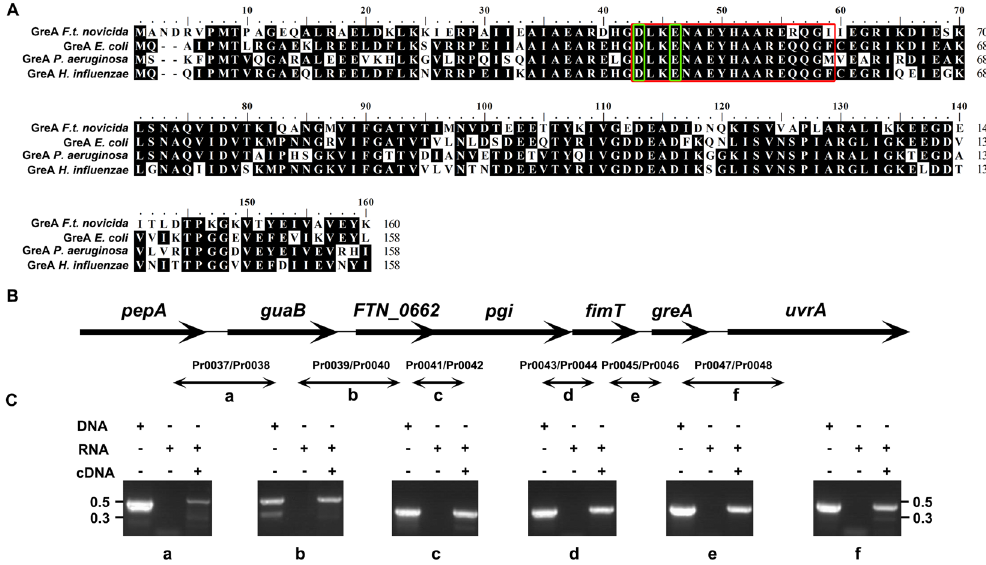
Figure 1. Analysis of the F. novicida greA locus. ( A ) Alignment of four Gram-negative bacterial GreA amino acid sequences using the MegAlign program of the DNAstar Lasergene package (version 10). Identical amino acid residues are shown in black. The cross-link with the RNA 3 ′ -terminus is shown in a red box and the conserved acidic residues (D43 and E46) required for GreA activity are shown in green boxes. ( B ) Schematic illustration of the gene arrangement at the greA locus. ( C ) Cotranscription of the greA locus genes determined with RT–PCR. The pepA-–guaB (a), guaB– FTN_0662 (b), FTN_0662 –pgi (c), pgi–fimT (d), fimT–greA (e), and greA–uvrA (f) junctions were amplified using DNA, DNA-free RNA, or cDNA as the template. The images were acquired by the gel imaging system (LIUYI, Beijing, China). The experiment was repeated twice. The sizes of the molecular markers are indicated at the side in